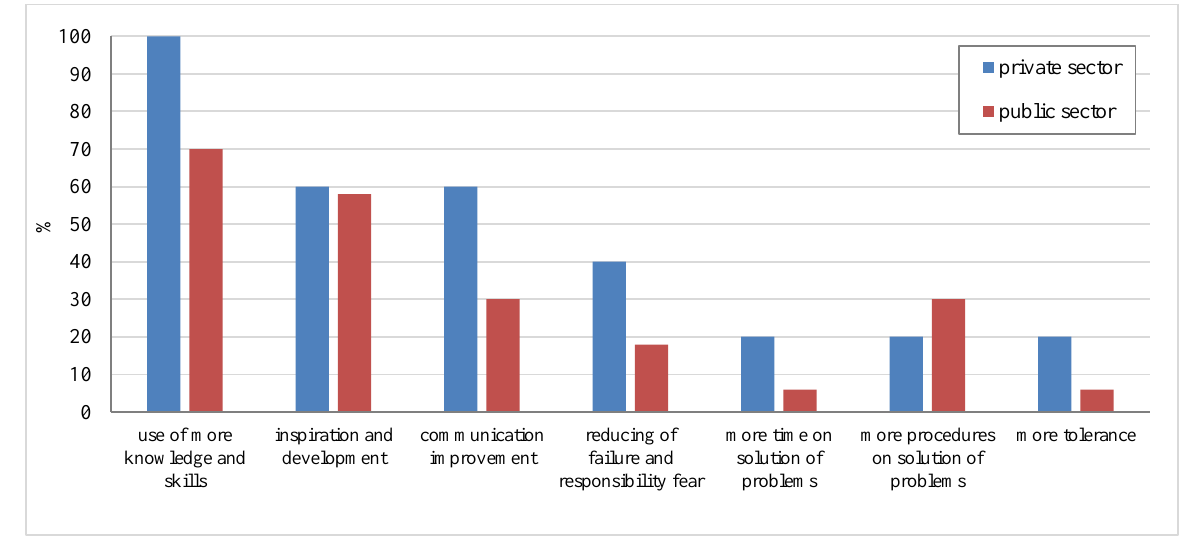
Figure 3. What positives do you perceive in your teamwork?